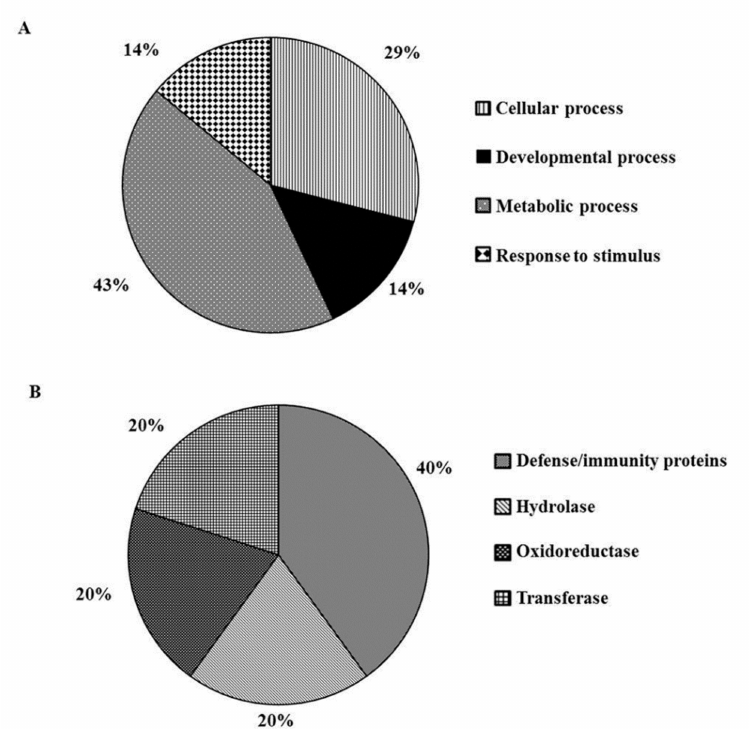
Figure 2. Functional classification of the 32 DEPs after MeJA treatment, using Protein Annotation Through Evolutionary Relationship (PANTHER) gene ontology (GO) analysis. The proteins were classified into ( A ) biological processes and ( B ) protein